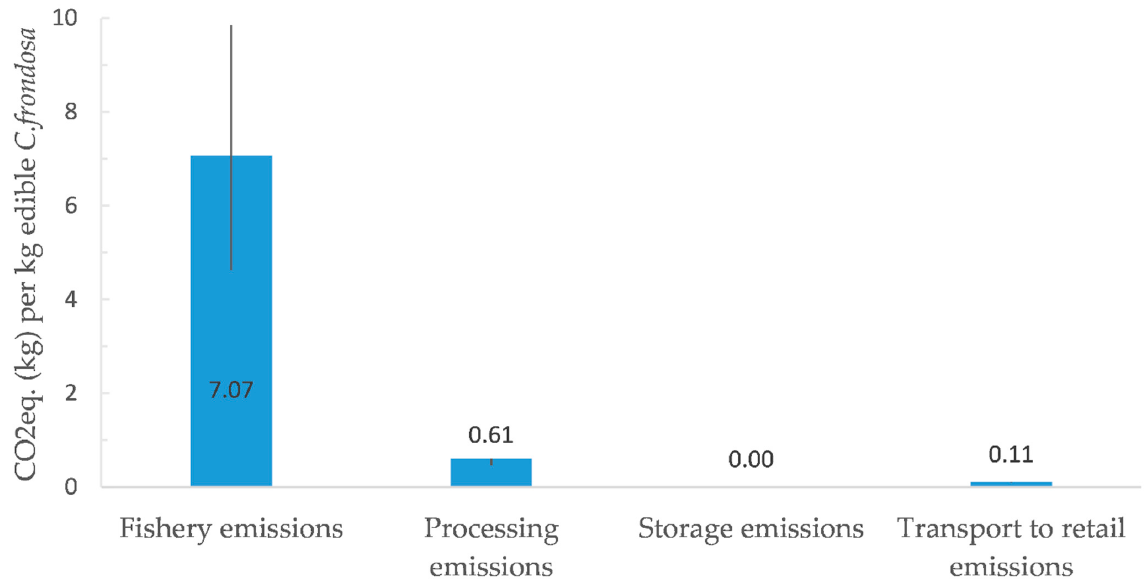
Figure 3. Estimated carbon dioxide equivalent (CO 2 eq.) emissions for orange-footed sea cucumber ( Cucumaria frondosa ) at the fishery-, production- (cooking and drying), storing-, and transport stage. The error bars represent the minimum and maximum estimates. Table 7. Amount of micro- and macronutrients per 100 g wet weight body-wall of orange-footed